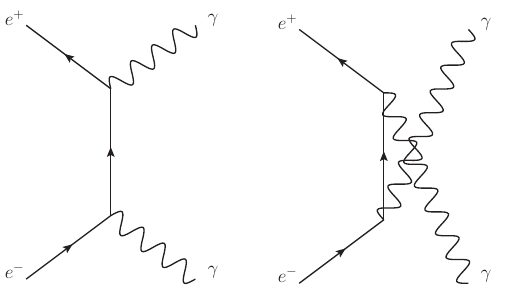
Figure 4: Feynman diagrams for pair annihilation to photons, e − e − → γγ , in the t (left) and u (right)